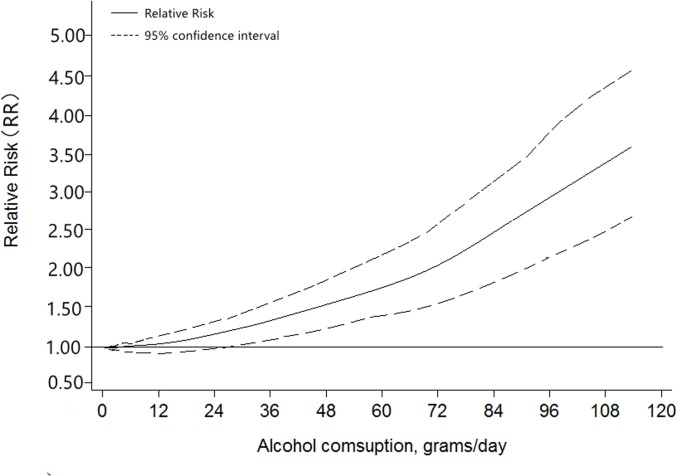
Relative risk function and 95% confidence intervals for the association between alcohol consumption per day and HNC.